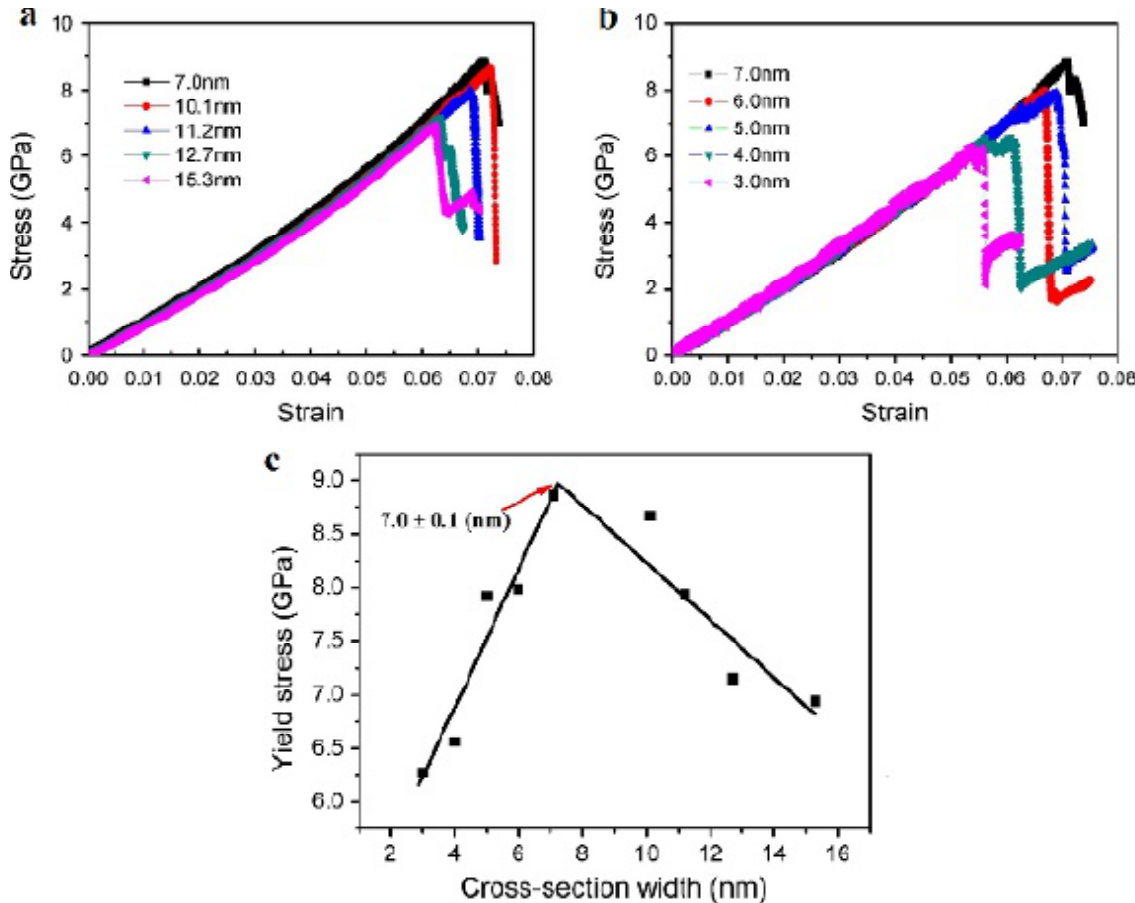
Fig. 36. Compressive stress–strain curves of Ti nanopillars with a) widths greater than 7 nm and (b) less than 7 nm, (c) the effect of pillar width on the yield strength. Reprinted with permission from Ren JQ, Sun QY, Xiao L, Ding XD, Sun J. 2013. Molecular dynamics simulations of the size effect of titanium single- crystal nanopillars orientated for double prismatic slips. Philosophical Magazine Letters 93, [262]. © 2013 Informa UK